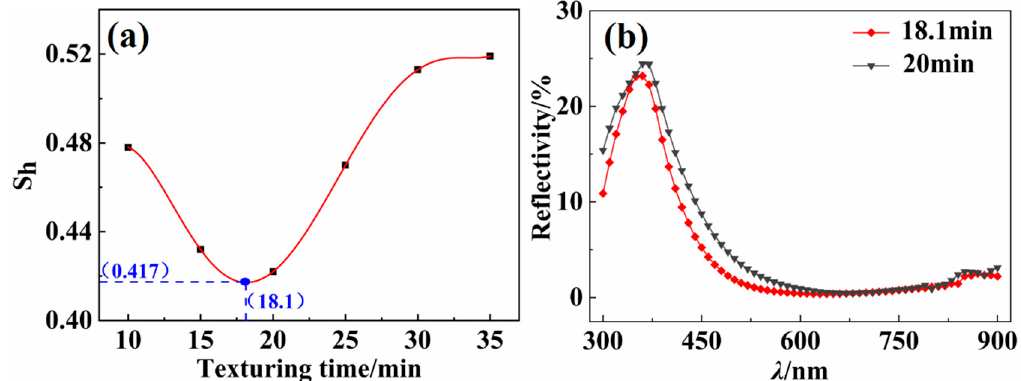
Figure 11. ( a ) A polynomial fitting by the relationship curve between the texturing time and S h . ( b ) The reflectivity of the silicon cell before and after process optimization of each group of 20 wafers is calculated, the reflectivity of the silicon cell textured for 18.1 min is significantly lower than that of the silicon cell textured for 20 min at the short wavelengths ( λ ) of 300–600 nm. The weighted reflectance of the optimized silicon cell is 2.28% at the full wavelength, which is 0.20% lower than that of the silicon cell textured for 20 min.